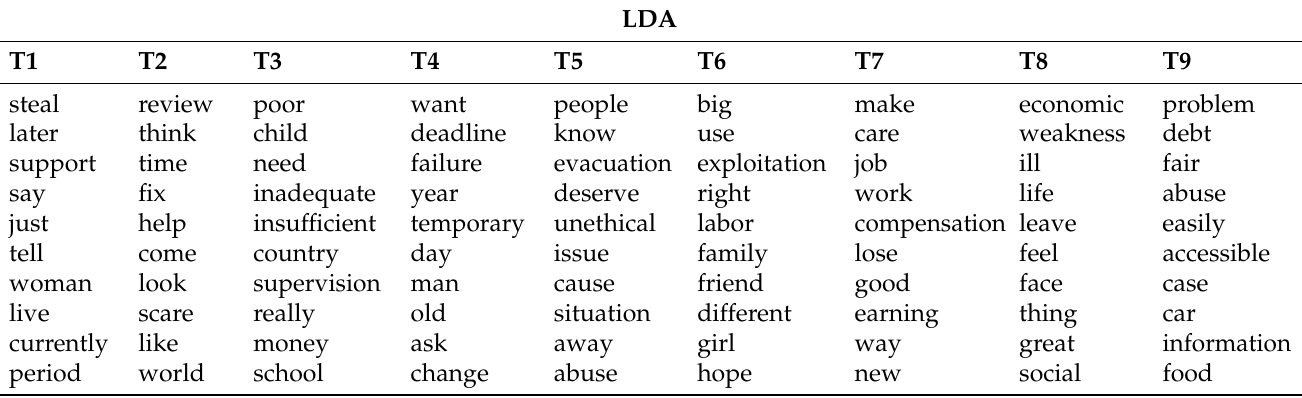
Table 4. Collection of topics and the top 10 keywords of the corresponding topic represented by the LDA